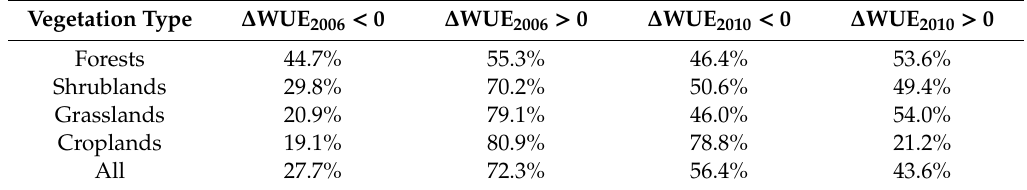
Table 3. Percentages of grid cells with ∆ WUE > 0 and ∆ WUE < 0 in 2006 and 2010 for di ff erent vegetation types and all vegetated areas in Southwest China.